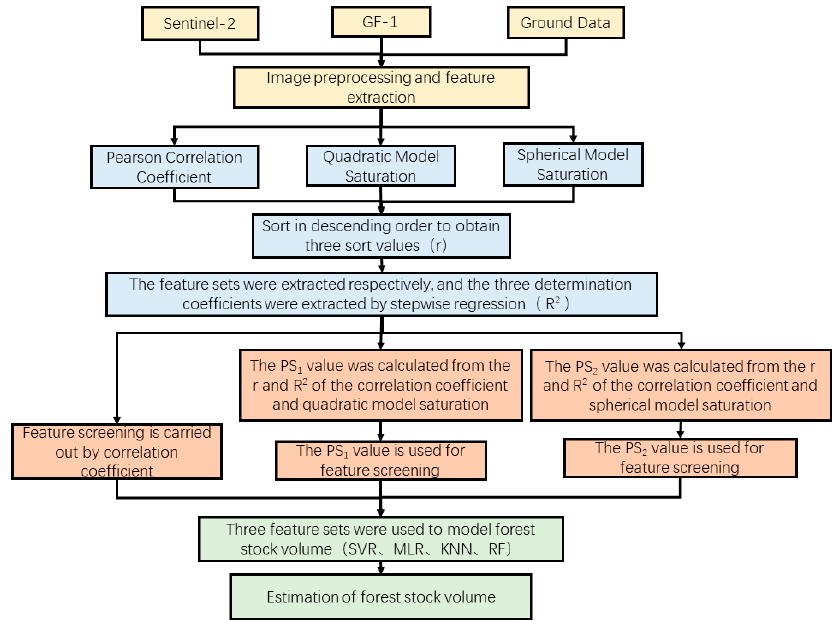
Figure 4. The framework of forest GSV estimation with new feature evaluation criteria based on spectral saturation.